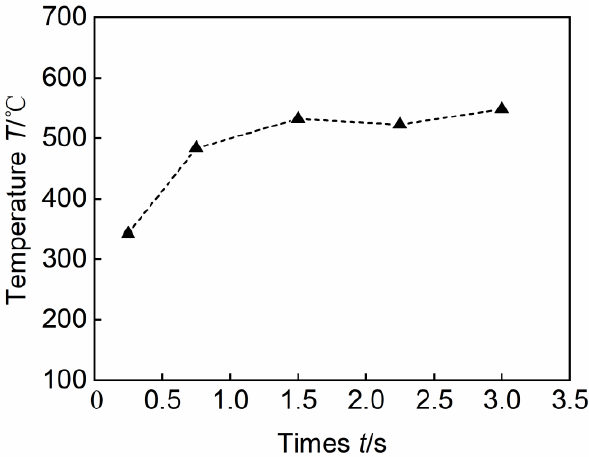
Figure 6. Interface temperatures in 6111 aluminum alloy to DC04 steel from the weld center under the welding pressure of 1.4 kN